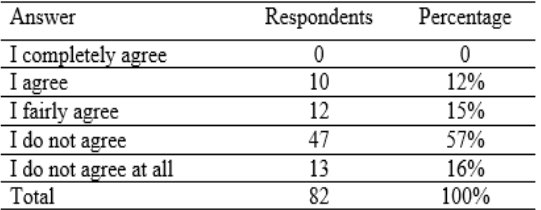
Table 1. Table of obtained answers to question